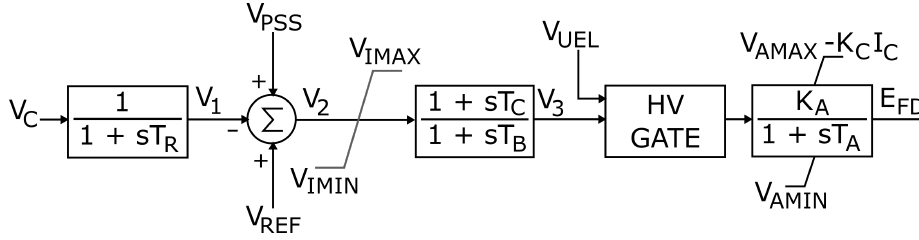
Figure 7. Block diagram of the excitation system type IEEE AC4A